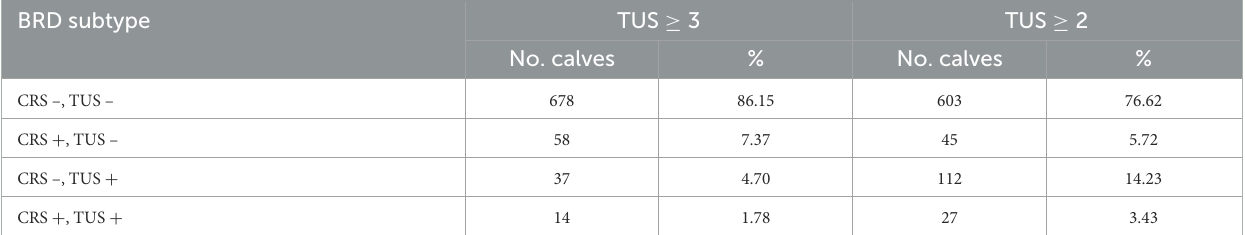
TABLE 2 Summary of the BRD subtypes